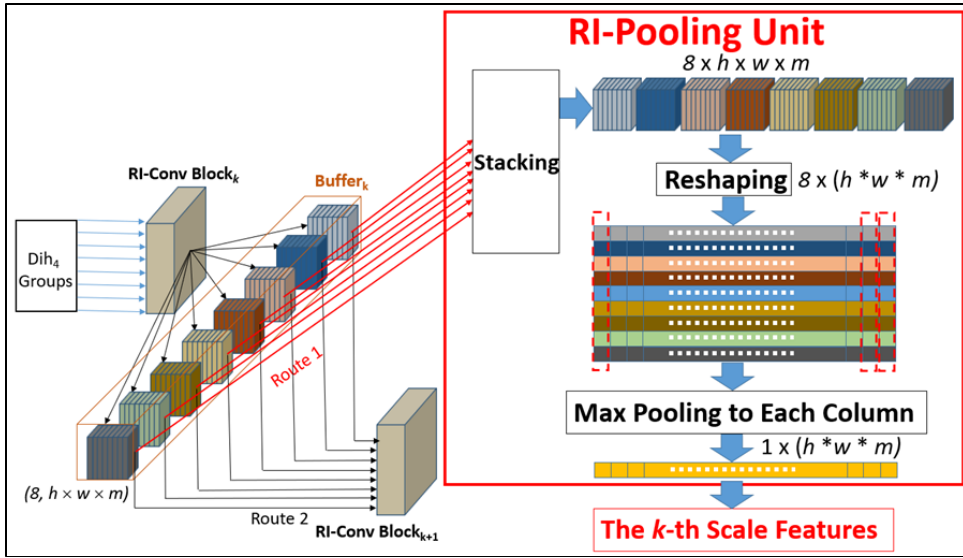
Figure 9. Three procedures of rotation-invariant pooling unit.